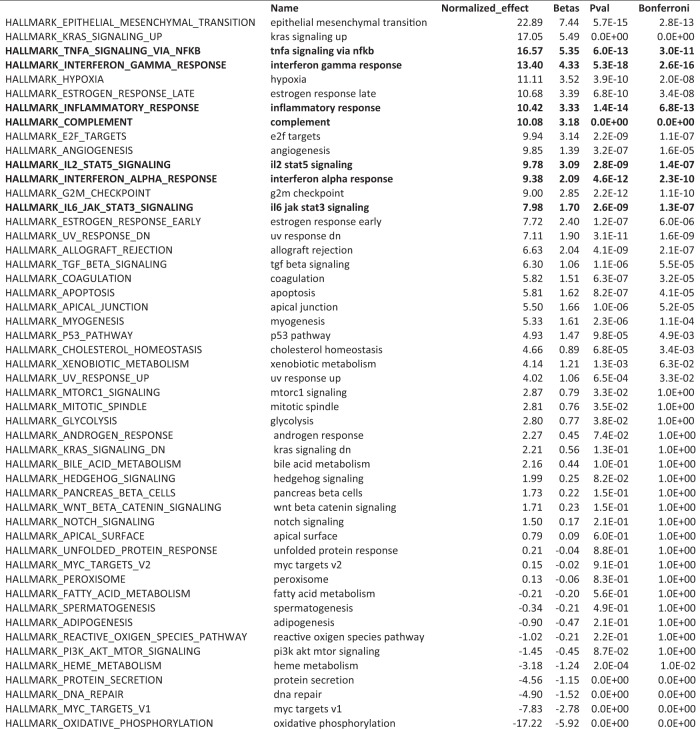
DLA identifies biological processes common to diseases that perturb the juvenile plasticity signature. To identify shared pathophysiology across the diverse list of diseases predicted to dysregulate the juvenile plasticity signature, we applied DLA. This approach calculates the association between diseases that dysregulate the plasticity signature genes and 50 well defined and distinct biological pathways. To do so, it computes a regression between the molecular match score (a measure that indicates the strength of association between the disease and plasticity signatures; see Table 3 and Materials and Methods) and the pathology score (a measure of activity of the biological pathway in that disease; see Materials and Methods). Large regression coefficients indicate that the biological pathway may disrupt juvenile plasticity. Using a multiple test-corrected, empirical p < 5 × 10−5, seven of the 14 largest DLA associations were inflammation-related gene sets, and every inflammation-related gene set in the hallmark library was strongly associated with diseases that dysregulate plasticity genes (seven of seven inflammation gene sets at pcorrected < 5 × 10−5: OR = 25.8, 95% CI = 1.4–491.2, p = 2.7 × 10−3, Fisher’s exact test). A total of 20,000 permutations of the gene sets was used to estimate p values and to normalize the regression coefficients to allow comparison between effect sizes for different biological pathways. Inflammation-related gene sets: TNF-α signaling via NF-κB, IFN-γ response, inflammatory response, complement, IL-2–Stat5 signaling, IFN-α response, IL-6–Jak–Stat3 signaling.